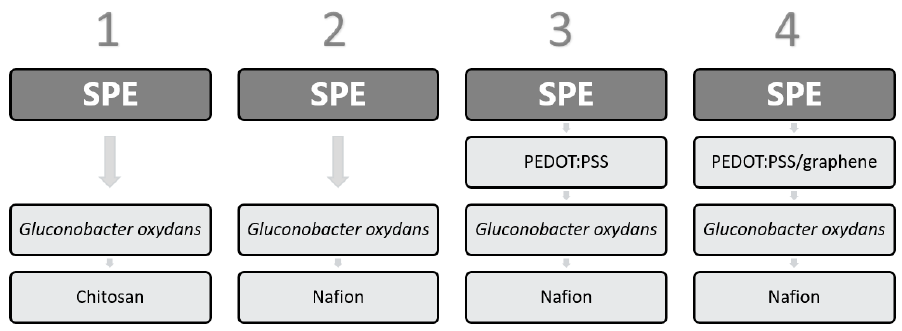
Figure 1. Biosensor formation protocols.